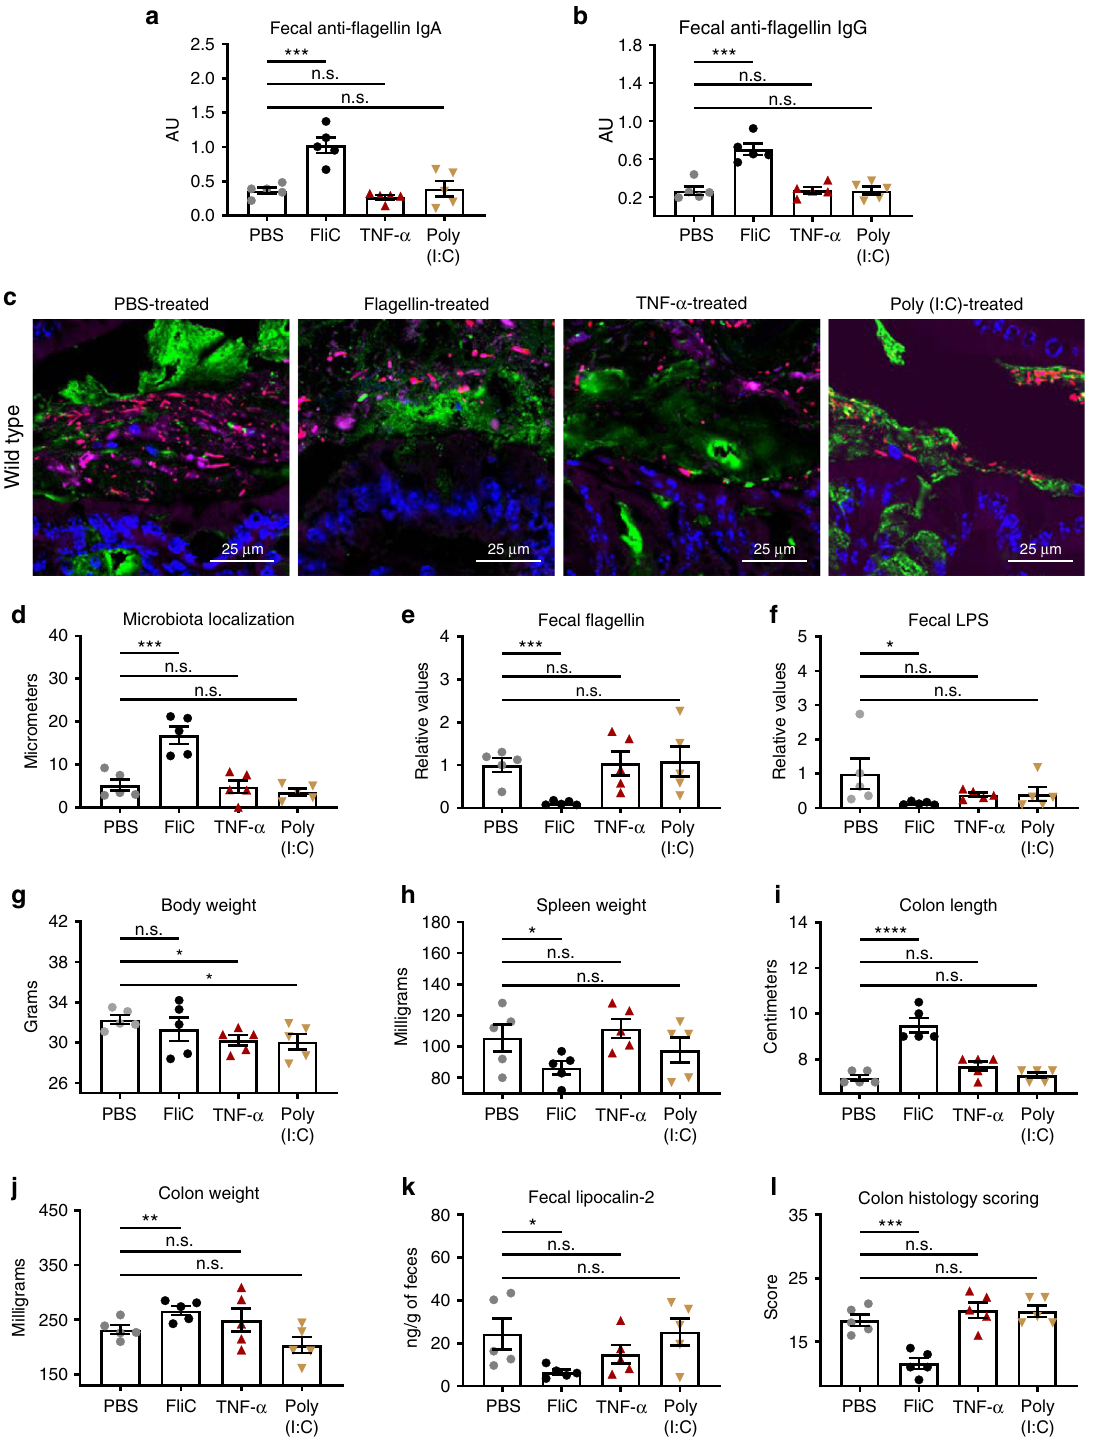
Fig. 6 Speci fi city of the bene fi cial effects induced by fl agellin immunization. 4-week old C57BL/6 J, wild-type mice, were purchased from The